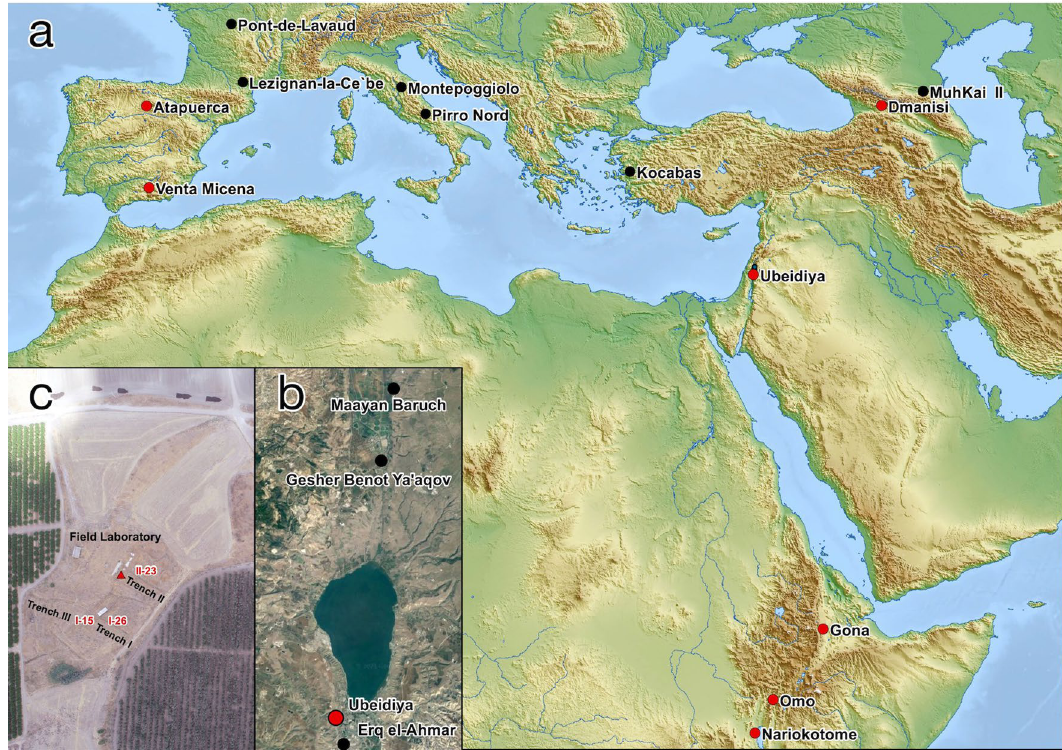
Figure 1. ‘Ubeidya site locality. ( a ) Map of Africa and Eurasia with major Pleistocene paleoanthropological sites. Black circles denote sites with no osteological remains; red circles denote sites with human osteological remains. ( b ) The location of the site of ‘Ubeidiya, south of lake Kineret (Sea of Galilee), on the western banks of the Jordan Valley (red circle) ( c ) aerial photograph of the excavation plan of ‘Ubeidiya with the location of layer II-23 where UB 10749 was